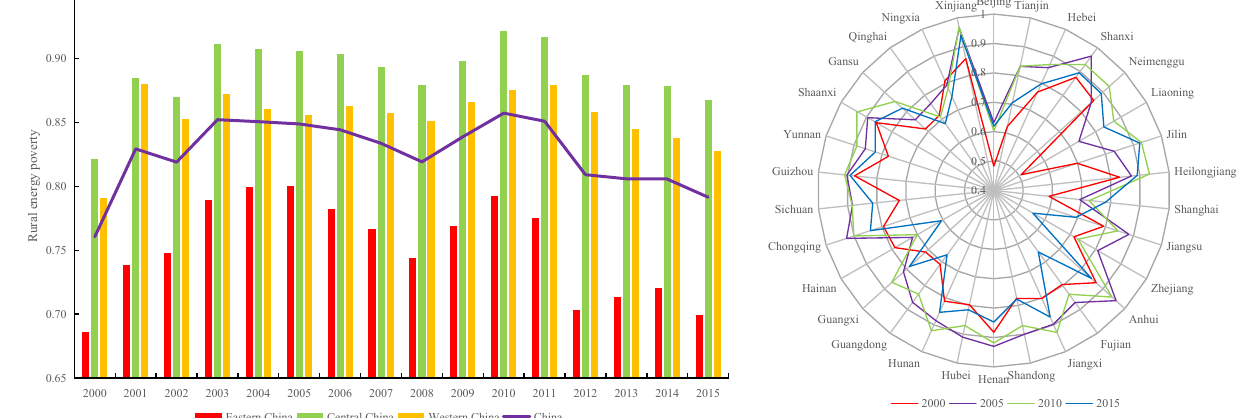
Figure 1. Rural energy poverty in China, 2000–2015. Note: Eastern China: Beijing, Tianjin, Hebei, Liaoning, Shanghai, Jiangsu, Zhejiang, Fujian, Shandong, Guangdong, and Hainan; Central China: Shanxi, Jilin, Heilongjiang, Anhui, Jiangxi, Henan, Hubei, and Hunan; Western China: Inner Mon- golia, Chongqing, Sichuan, Guizhou, Yunnan, Tibet, Shaanxi, Gansu, Qinghai, Ningxia, Xinjiang, and Guangxi.